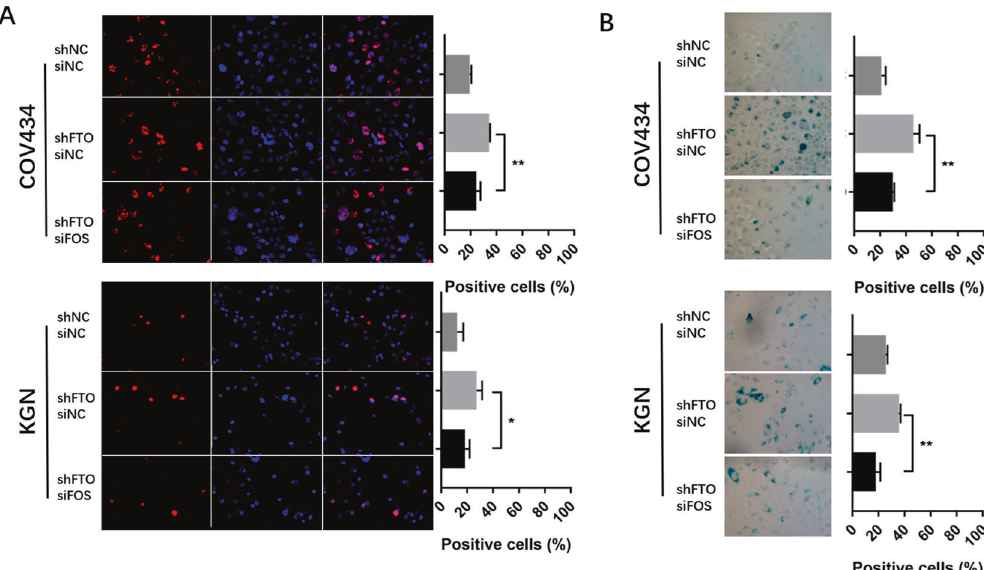
Fig. 5 Silencing FOS partially alleviated FTO-dependent aging in COV434 and KGN cells. Immuno fl uorescence of γ H2A. X ( A ) and β -galactosidase staining ( B ) in FTO-silenced and FOS-silenced KGN and COV434 cells more readily entered senescence induced by hydrogen peroxide. All experiments were performed three times. The error bars indicate SD; * p < 0.05, ** p < 0.01, *** p < 0.001. All experiments were performed three times, and three microscopic images were counted in each group. The error bars indicate SD; * p < 0.05, ** p < 0.01, *** p <